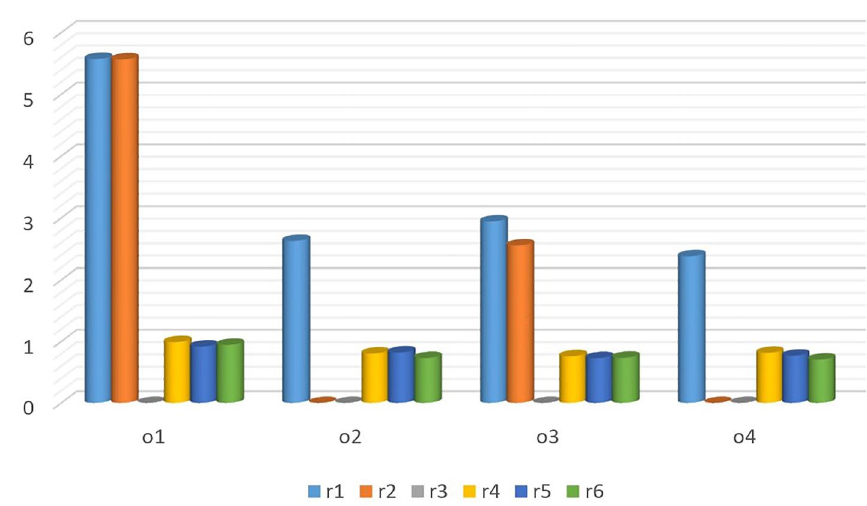
Figure 7. Ranking of EVCS based on different